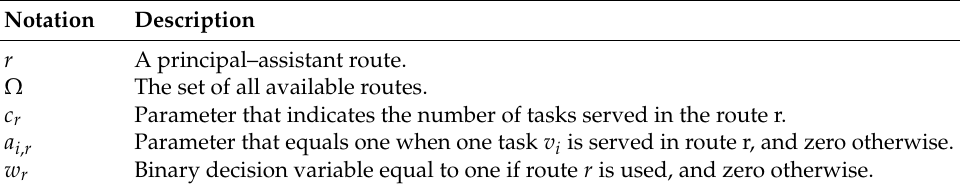
Table 3. Parameters and variables for the m -principal- u -assistant